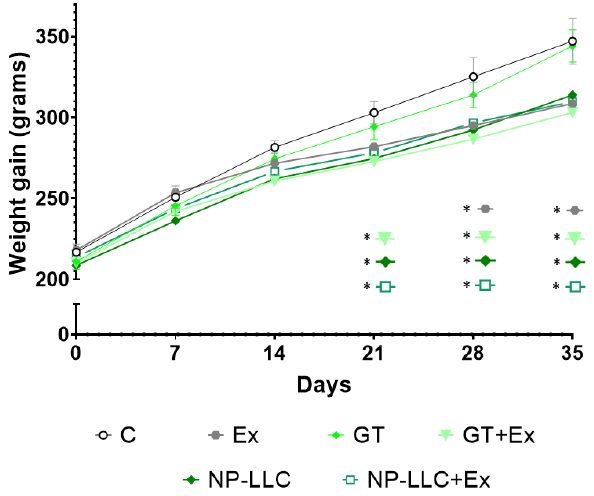
Figure 1. Evolution of the animals’ body mass over the weeks. Note: * p < 0.05 when compared to Control.